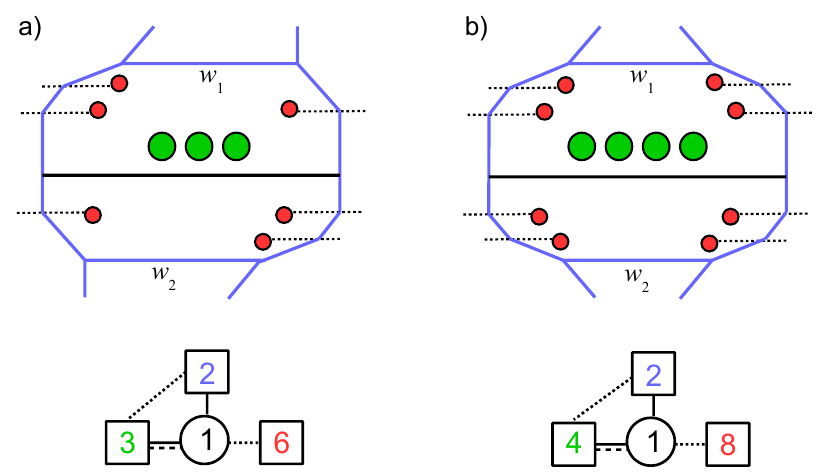
Figure 8 . Partial completion of the brane systems for the L 1 bubbling in the SU(3) and SU(4) theories and semi-improved